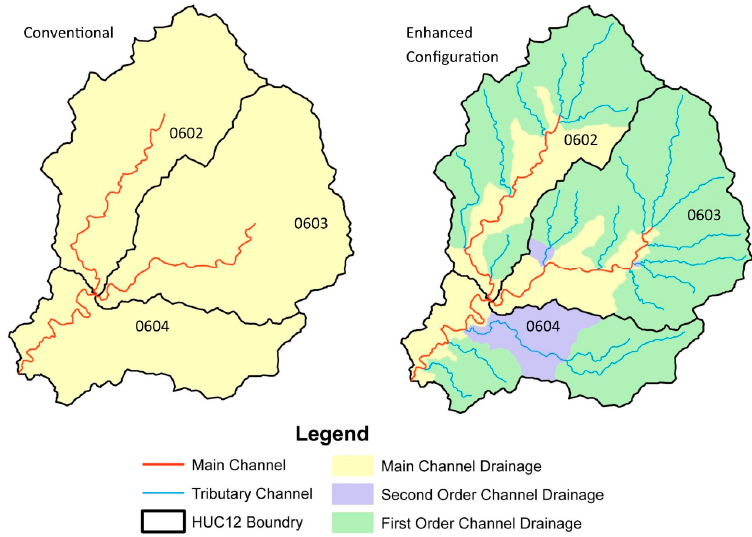
Figure 4. Conventional Soil and Water Assessment Tool (SWAT) and enhanced SWAT+ subbasin and stream configurations. Located in USGS HUC8 12090107, and the last four digits of HUC-12 code shown.